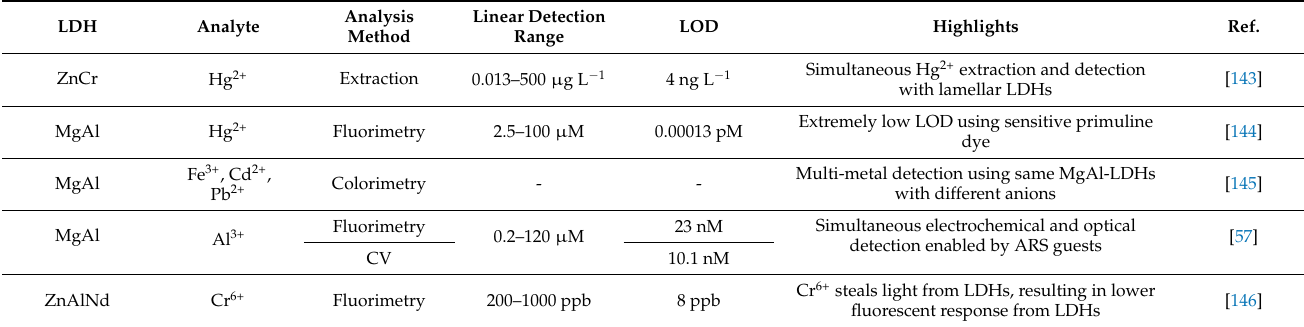
Table 5. The detection performance of LDH-based metal ion